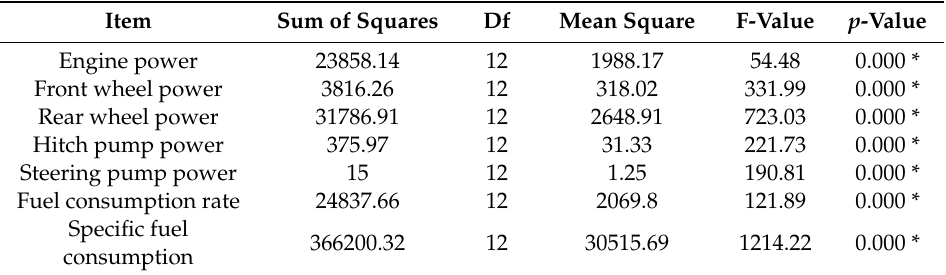
Table 5. One-way analyses of variance (ANOVA) results for analysis tillage depth e ff ects.